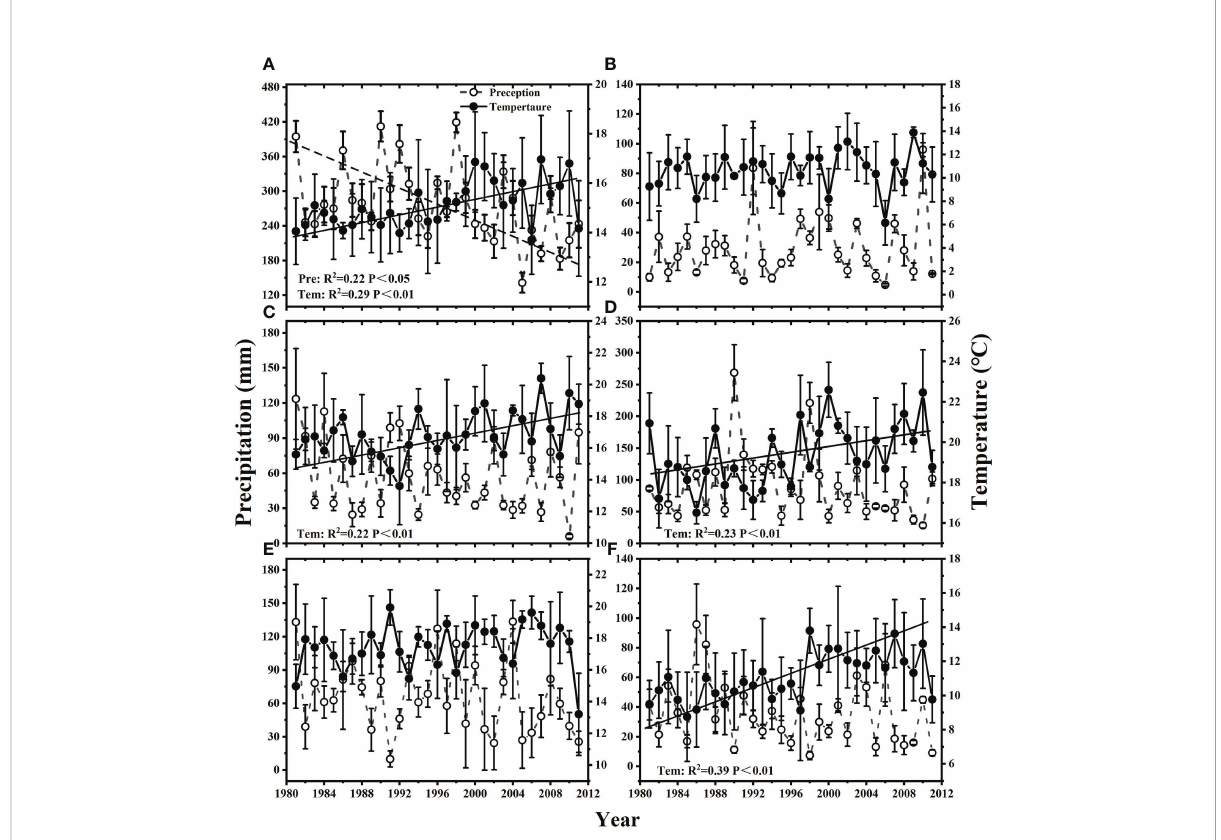
FIGURE 1 Changes of mean precipitation and mean temperature from 1981 to 2011 during (A) the growing season (GS), and the month of (B) May, (C) June, (D) July, (E) August and (F)